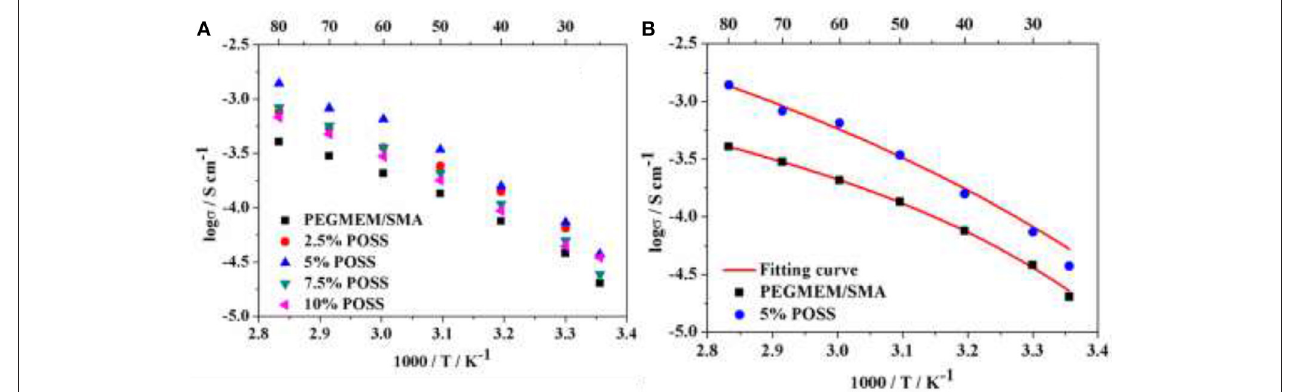
FIGURE 5 | (A) Temperature-dependent ionic conductivity of HPEs with various POSS contents with [EO]/[Li] of 10/1; (B) VTF fitting results of HPEs based on HCP with 5% POSS and the PEGMEM/SMA